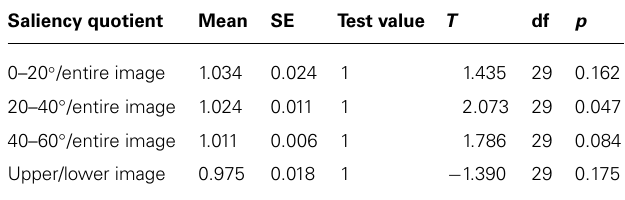
r, Correlation coefficient.